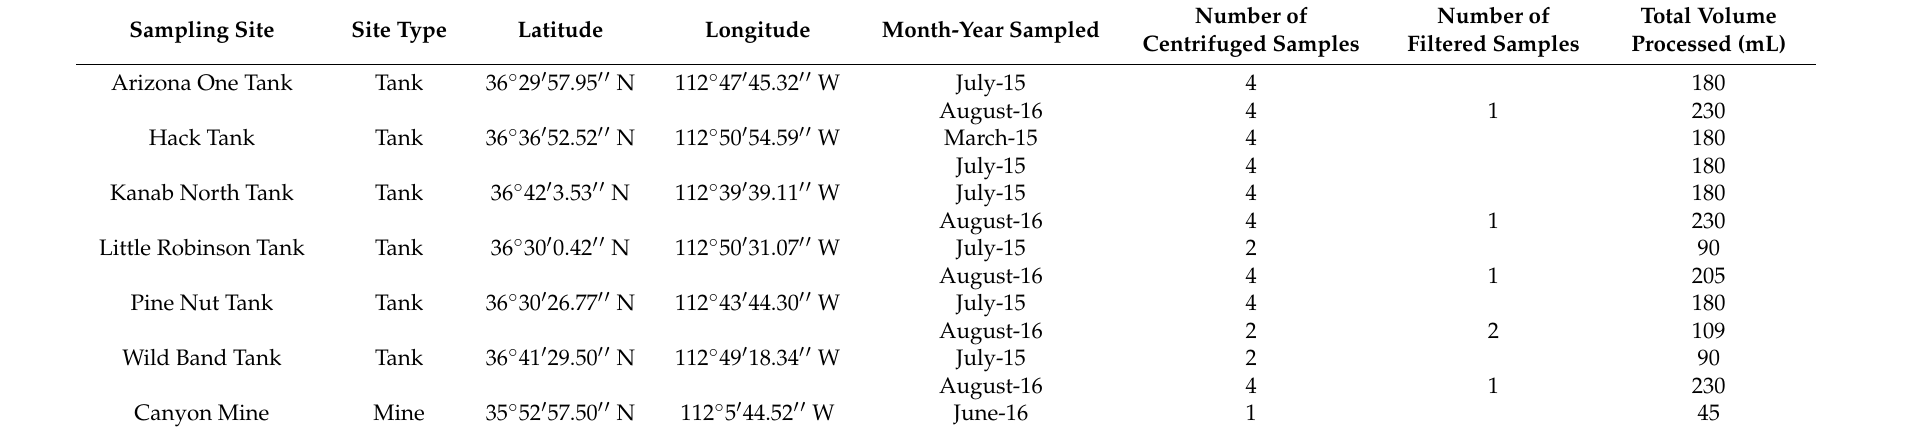
Table 1. List of sampling sites, number and types of samples, and total volume processed for each site.